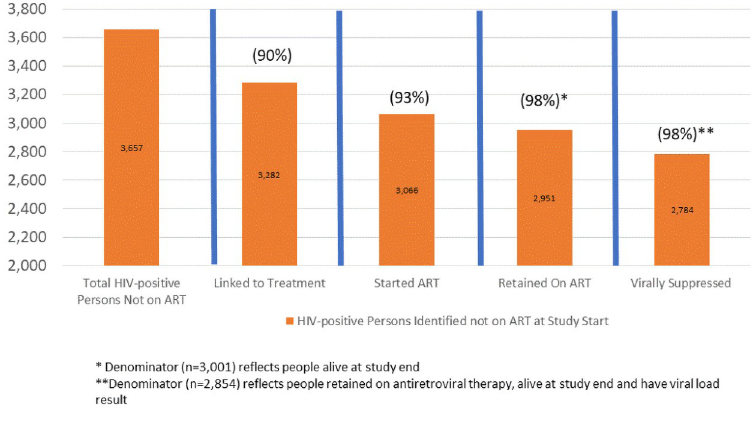
Fig 3. Longitudinal HIV care cascade among PLHIV not on ART and referred to treatment in 15 intervention communities.